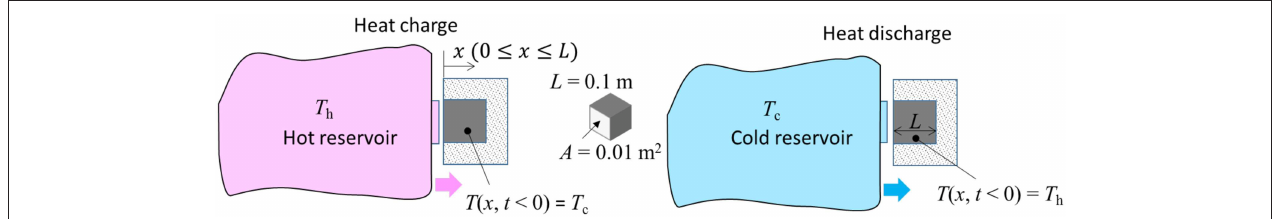
FIGURE 1 | Schematics of the physical representations of the cases of contacting a hot (Left) or cold (Right) reservoir. For both cases, temperature reservoir initially contacts the object block at t =